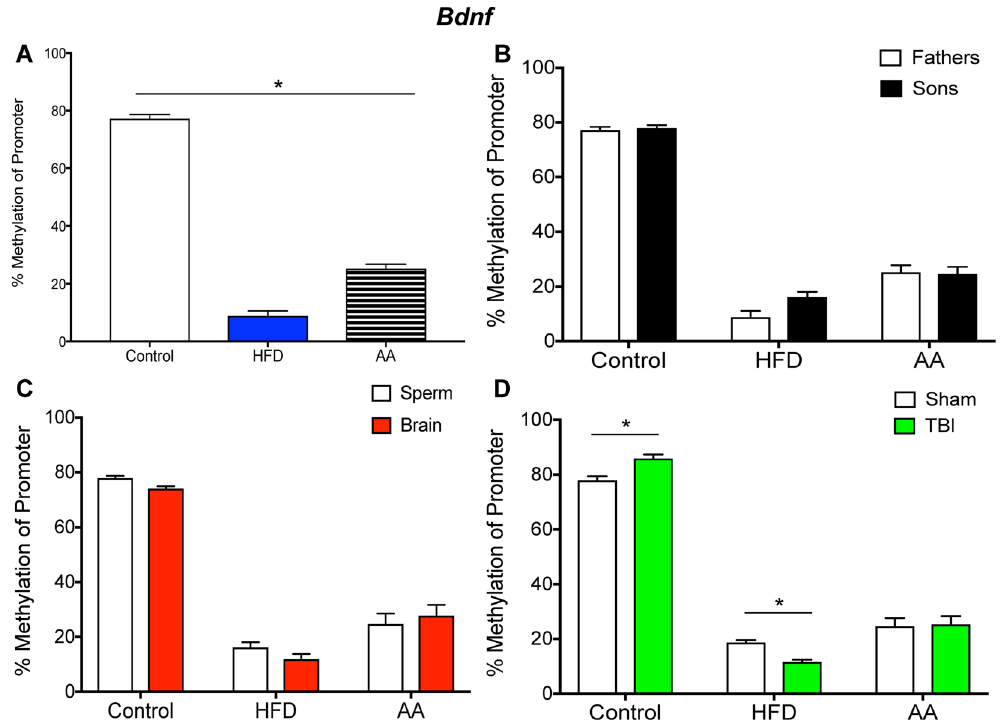
Figure 1. Illustrative demonstrations of Bdnf promoter methylation. One way ANOVAs were conducted and significant main effects are indicated ( * p < 0.05). ( A ) Average Bdnf promoter methylation in paternal sperm was significantly reduced in HFD and AA sperm compared to control sperm ( p < 0.05). ( B ) There were no significant differences in Bdnf promoter methylation between father and son sperm in either of the paternal treatment conditions ( p > 0.05). ( C ) There were no significant differences in Bdnf promoter methylation between sperm and brain of offspring ( p > 0.05). ( D ) mTBI in control offspring was associated with an increased Bdnf methylation whereas mTBI in HFD offspring was associated with decreased Bdnf promoter methylation ( p <